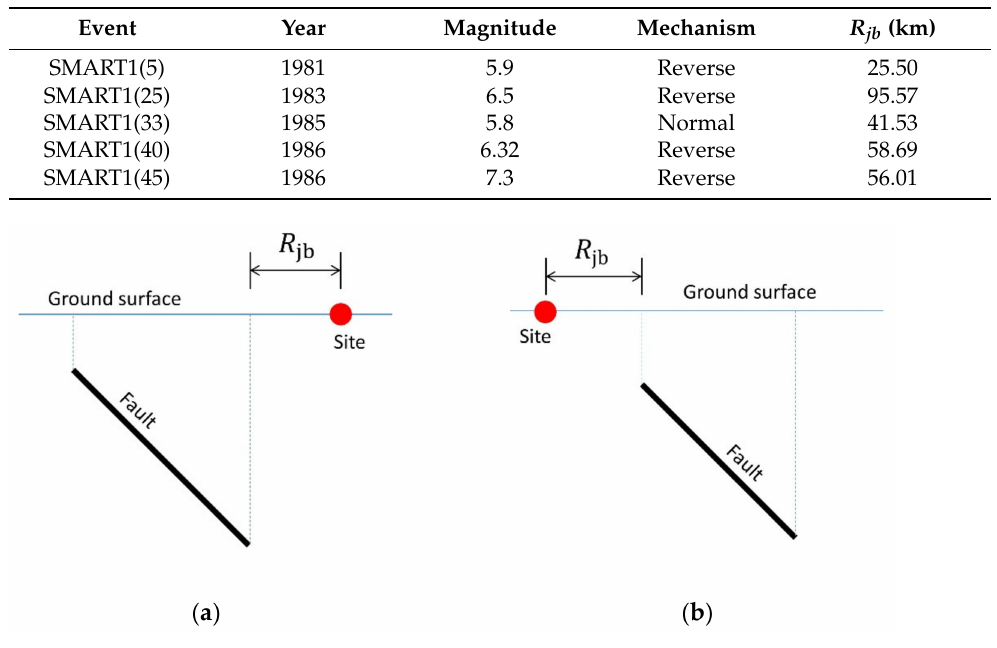
Figure 1. Illustration of the Joyner–Boore distance for reverse or normal faulting: ( a ) hanging wall site, ( b ) foot wall